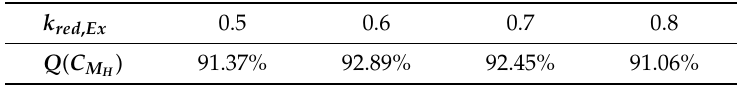
Table 2. Evaluation of fit factors for the application of harmonic aileron